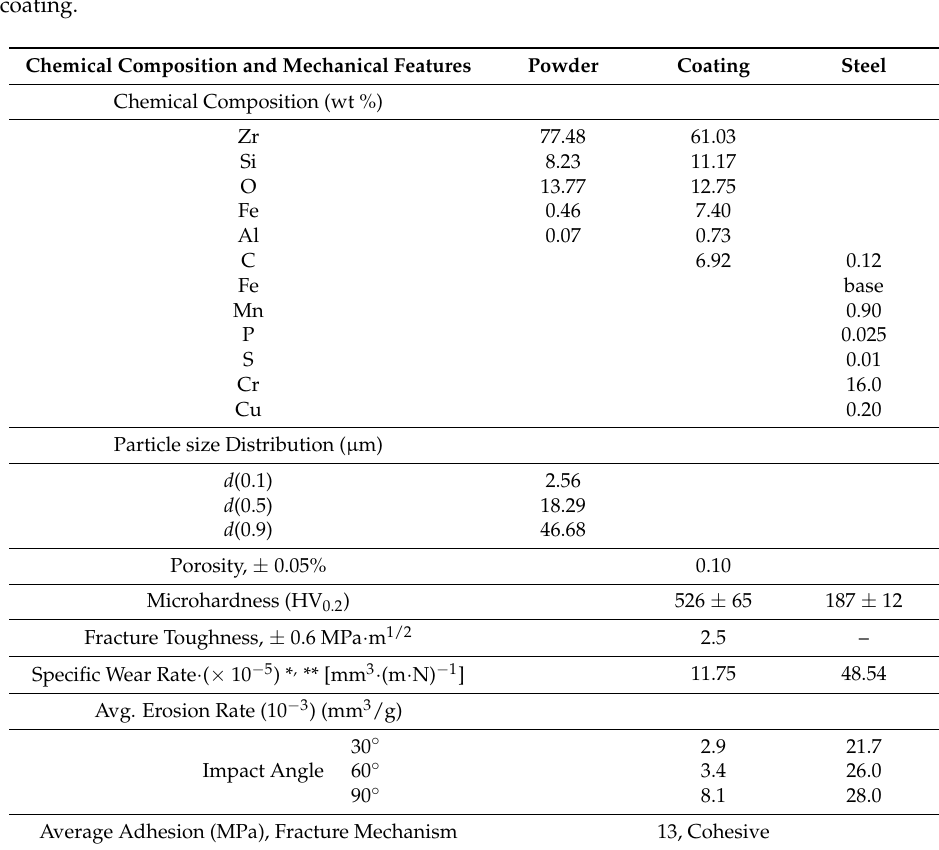
Figure 3. SEM micrographs of zircon powder (back ‐ scattered electron mode). ( a ) ×2000; ( b ) ×5000. Table 3. The chemical composition of the powder and coating, as well as the mechanical features of